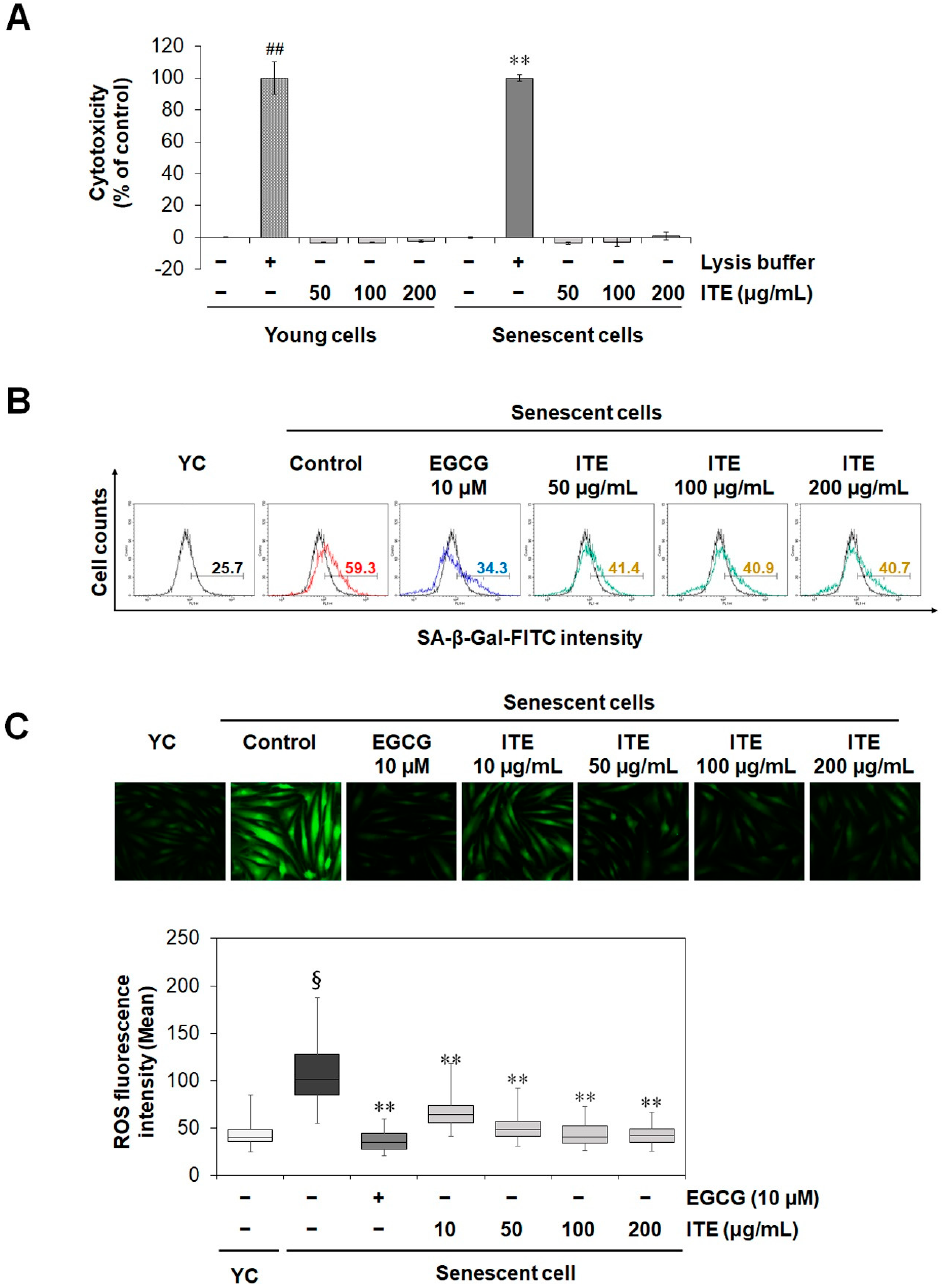
Figure 1. Inhibitory effect of ITE on SA- β -gal activity and oxidative stress in RS-HDFs. ( A ) The cytotoxicity of ITE in HDFs was determined by LDH assays. Lysis buffer was used as a positive control. ( B ) Representative flow cytometry plots are shown. Values inside the plots quantified the percentage of positively stained cells (SA- β -gal FITC-positive) detected by flow cytometry. ( C ) Images of HDF fluorescence induced by ROS are shown as DCF fluorescence emitting green fluorescence. Representative immunofluorescence images and fluorescence intensity analysis. The data are pre- sented as the mean ± standard error of the mean (SEM) of three independent assays. ## p < 0.01 or § p < 0.01 compared to young HDF controls, ** p < 0.01 compared to RS-HDF controls. YC, young cell controls.